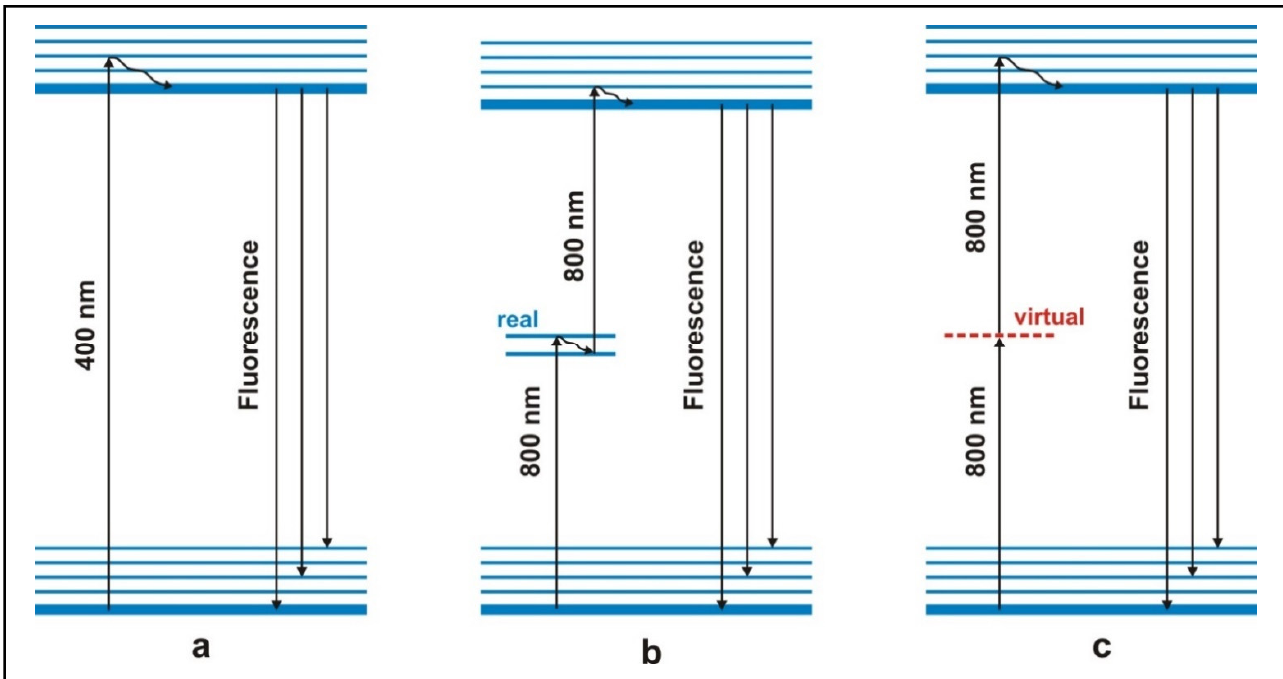
Figure 1. Different modes of excitation of fluorescence. ( a ) Left: conventional fluorescence excitation by one photon (e.g., 400 nm). ( b ) Middle: excitation by stepwise absorption of two photons via a real intermediate energy level (e.g., 800 nm, preferably from a nanosecond laser). PRINCIPLE OF DERMATOFLUOROSCOPY. ( c ) Right: excitation by simultaneous absorption of two photons via virtual energy level (e.g., 800 nm, preferably from a femtosecond laser). This mode of excitation is used in femtosecond laser spectroscopy. Due to the small cross-section, a nanosecond (ns) pulse excitation with tolerable intensities gives rise to only an extremely weak fluorescence.